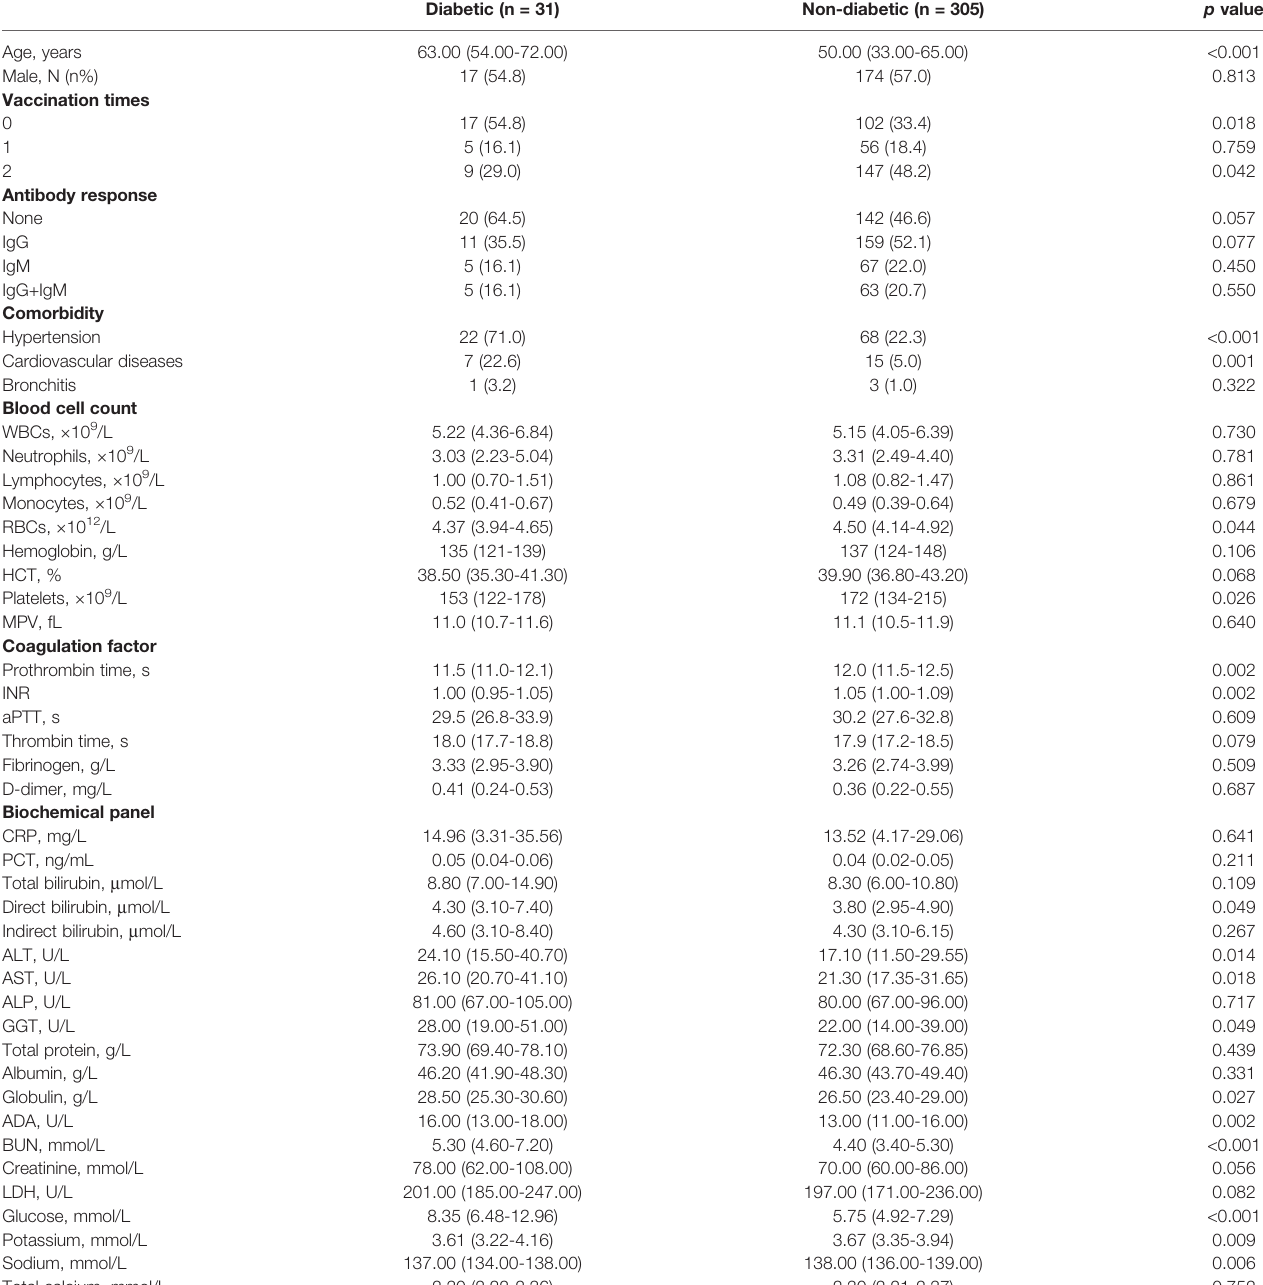
TABLE 2 | Comparison of clinical characteristics between diabetic and non-diabetic groups infected by the delta variant of SARS-CoV-2 in 2021. Diabetic (n = 31) Non-diabetic (n =